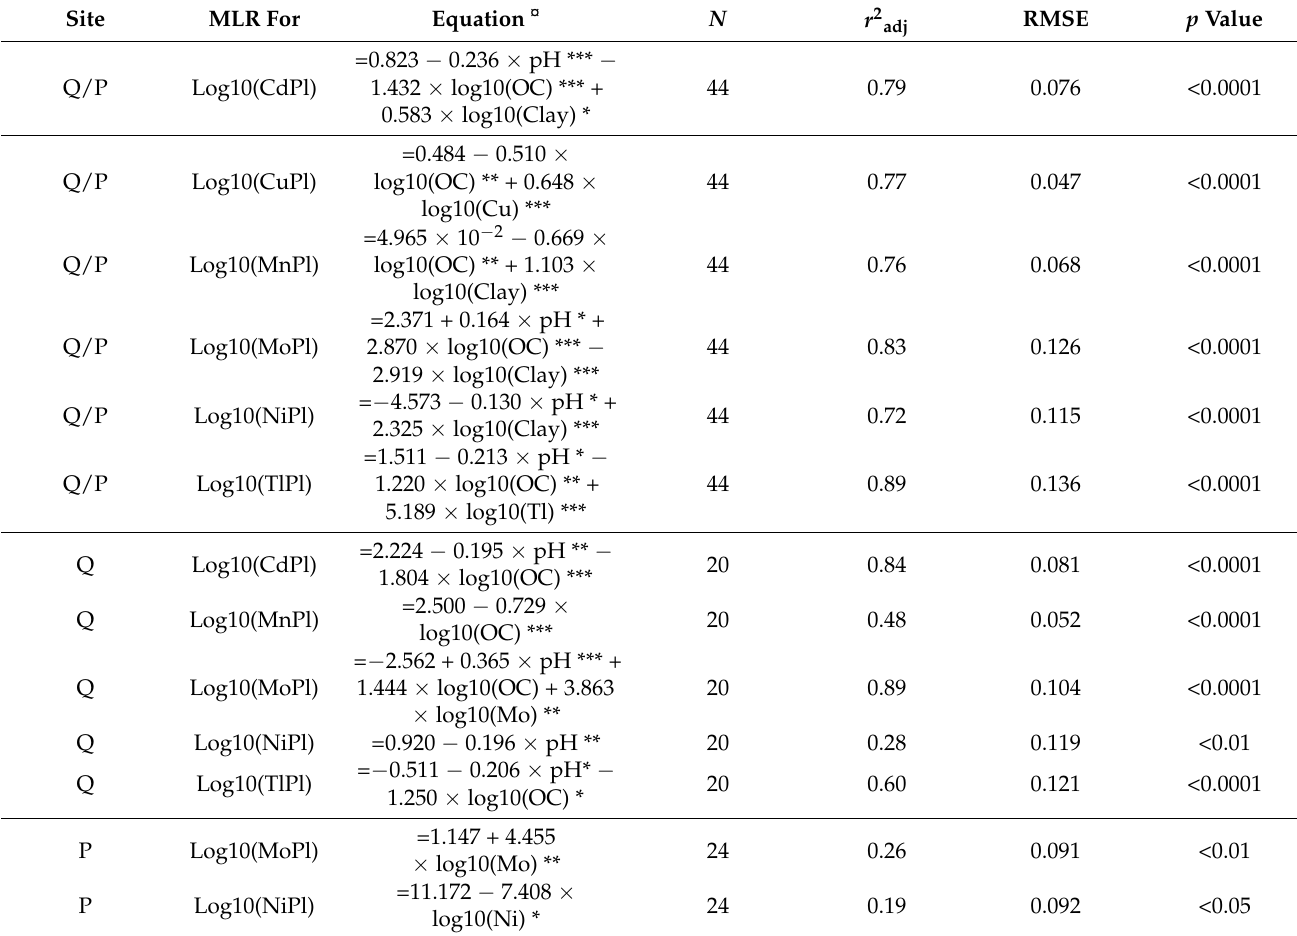
Table 9. Selected results of stepwise multiple log–log linear regression (MLR) studies and associated statistics, with the following data presented: Pl for Plantlet, Q for QualiAgro, P for PROspective and OC for organic